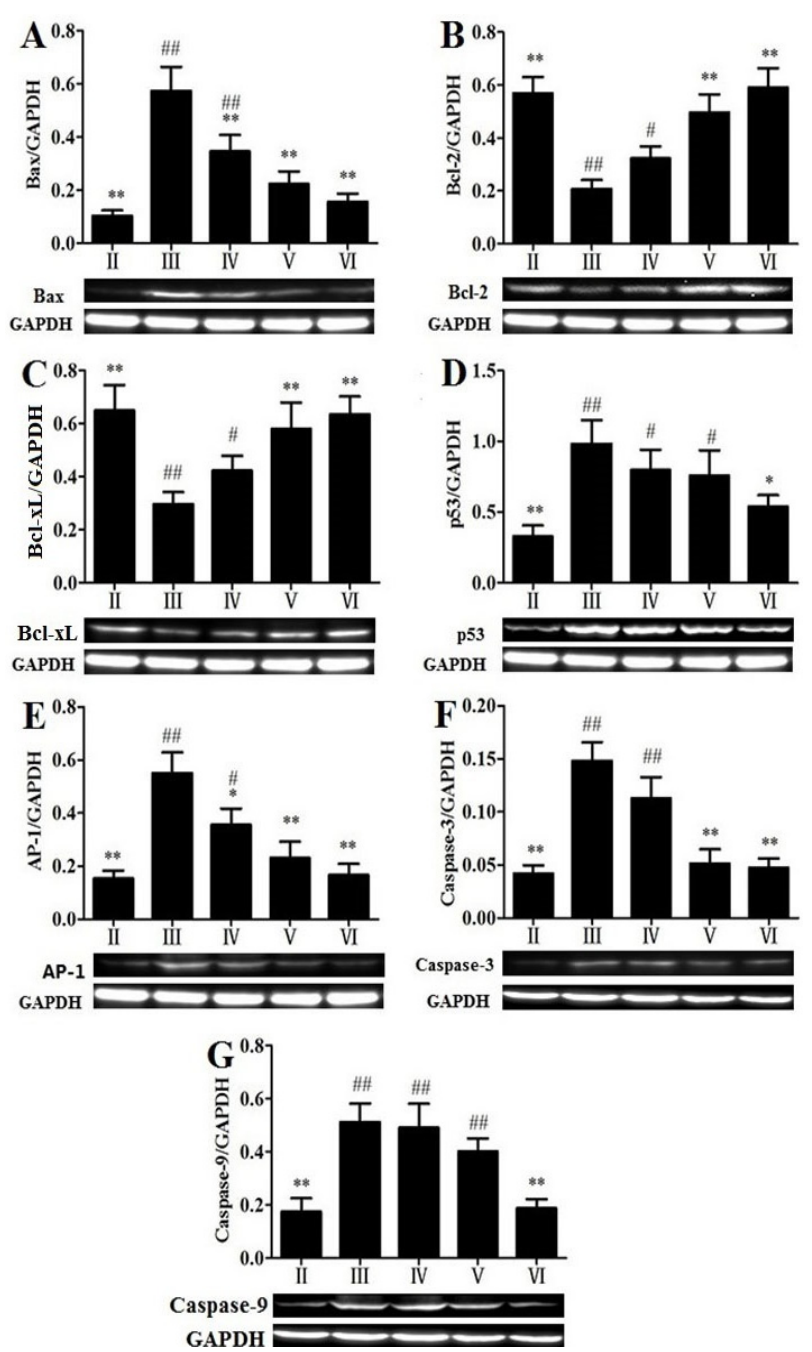
Figure 6. Effects of RLTS on the protein expressions of Bax ( A ), Bcl-2 ( B ), Bcl-xL ( C ), p53 ( D ), AP-1 ( E ), Caspase-3 ( F ), Caspase-9 ( G ). Values are expressed as mean ± SD ( n = 4). * p < 0.05, ** p < 0.01 vs. model group; ## p < 0.01, # p < 0.05 vs. normal